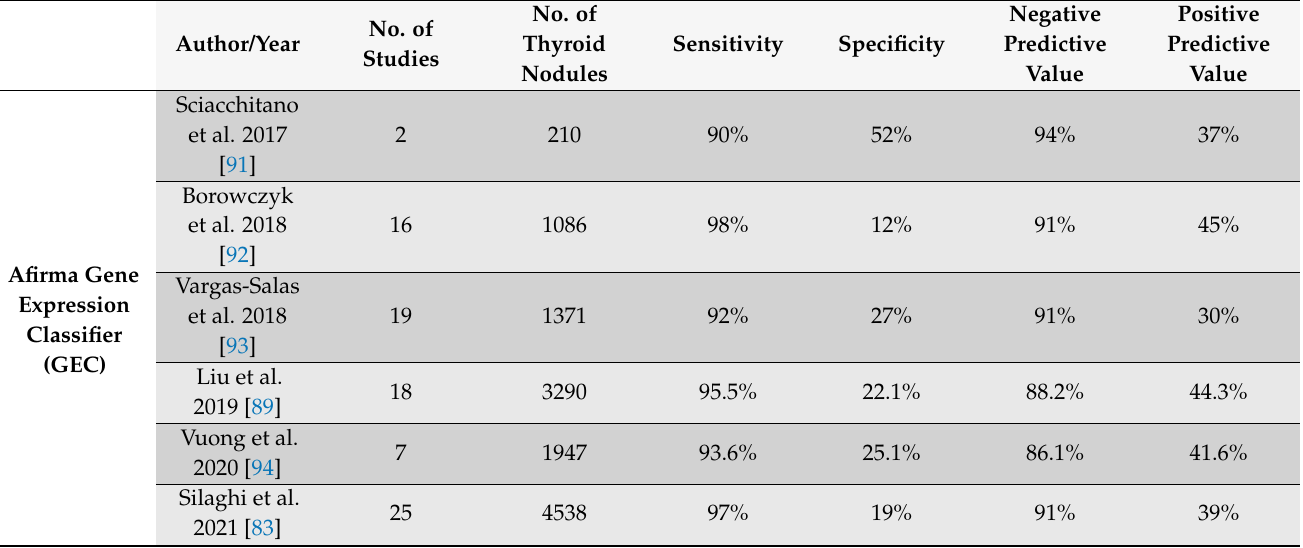
Table 5. Molecular panels diagnosing thyroid malignancy in patients with indeterminate thyroid nodules, a summary of published